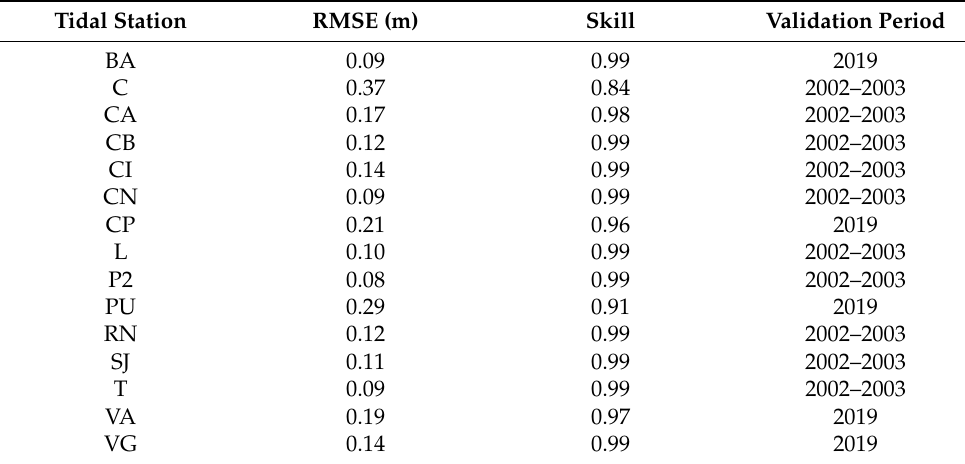
Table 7. Model performance under tidal propagation resulting from the calibration procedure. Tidal Station